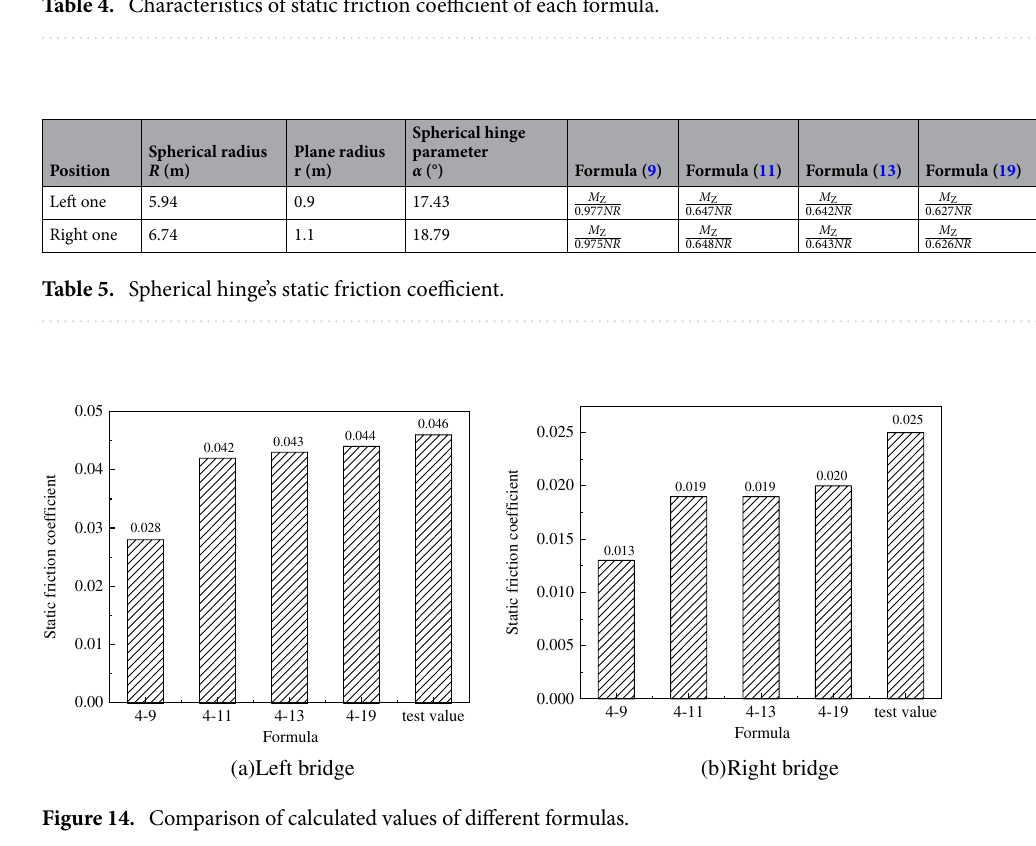
Table 4. Characteristics of static friction coefficient of each formula.